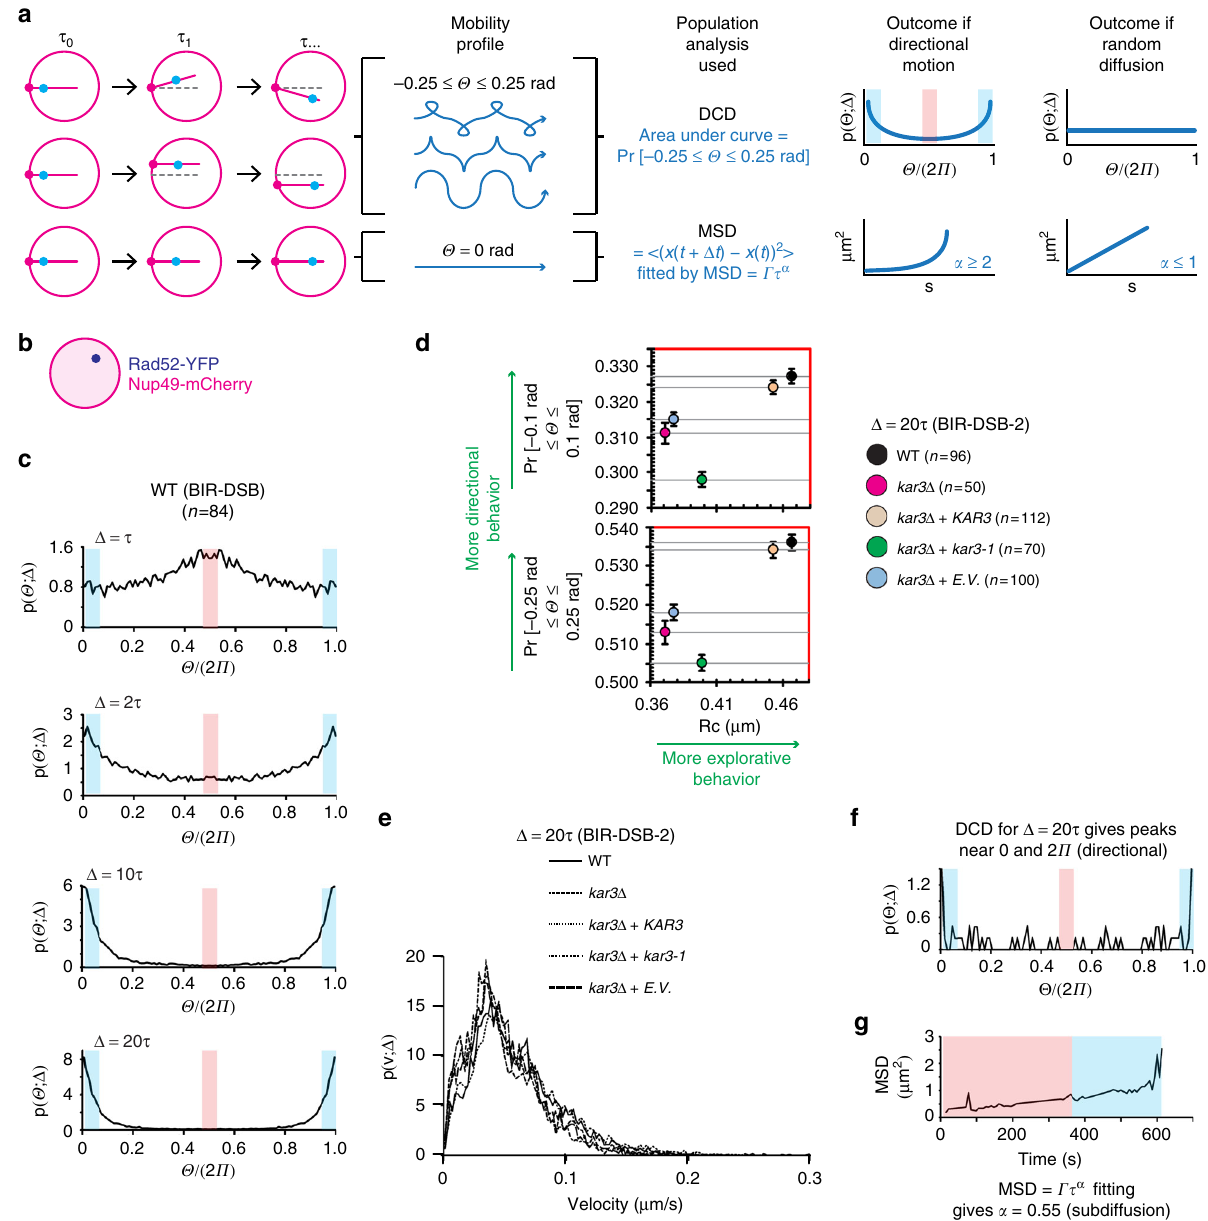
Fig. 3 Damaged DNA exhibits non-linear directional motion in the nucleus. a DIM (magenta sticks) angle ( Θ ) deviations of up to 0.25 rad from a straight line can cause DSB single particles (blue) to exhibit non-linear directional motion detectable by DCD, not MSD. b System used in DCD analysis of BIR- DSBs. Rad52-YFP-marked damaged DNA was tracked relative to the perinuclear Nup49-mCherry. c DCD analysis of damaged DNA mobility reveals non- linear directionality. Shown are relative angle distributions with indicated temporal coarse grainings ( Δ ) for a single induced BIR-DSB. Histograms are for Rad52-YFP particles monitored for 3 min using 1.5 s long steps. d DCD-derived probabilities of BIR-DSB-2 moving with up to 0.1 or 0.25 rad angle deviation from a straight line were plotted relative to MSD-derived R c values. Error bars, DCD probability errors. e DCD-derived distributions of the velocities of damaged DNA particles for cells shown in d . f , g Comparison of DCD ( f ) and MSD ( g ) analyses for a single damaged DNA particle shown in Fig. 2b and Supplementary Movie 1. Blue and red shading, respectively, highlight either ( f ) DCD peaks detecting directional and anti-directional behavior or ( g ) time windows during which the particle is known to exhibit directional or non-directional motion along DIMs in Supplementary Movie